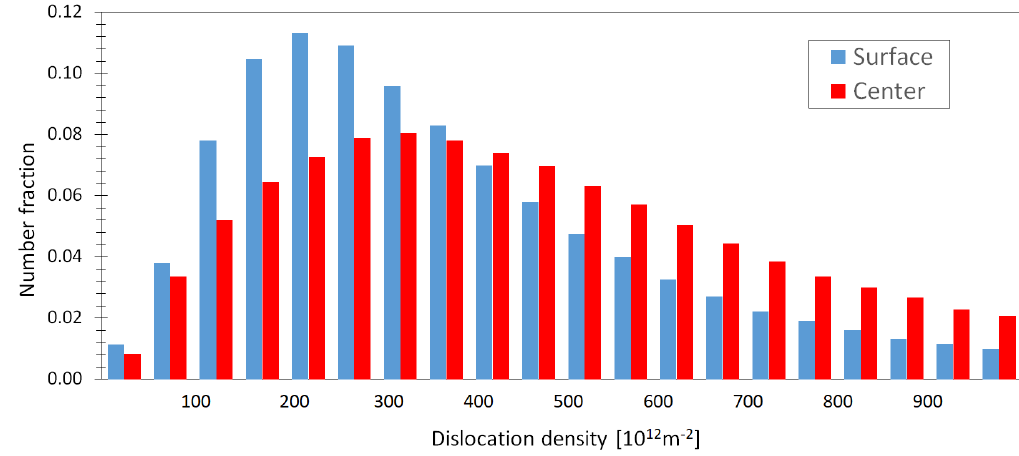
Figure 12. Density of geometrically necessary dislocations estimated in the bottom surface and the central section.